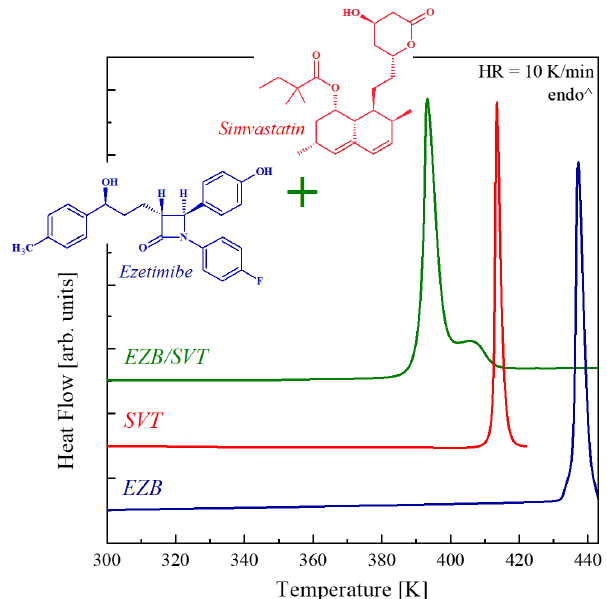
Figure 1. Differential scanning calorimetry (DSC) thermograms of the pure crystalline ezetimibe (EZB; blue line), pure crystalline simvastatin (SVT; red line), and EZB/SVT physical mixture ( green line) obtained during heating at 10 K/min.